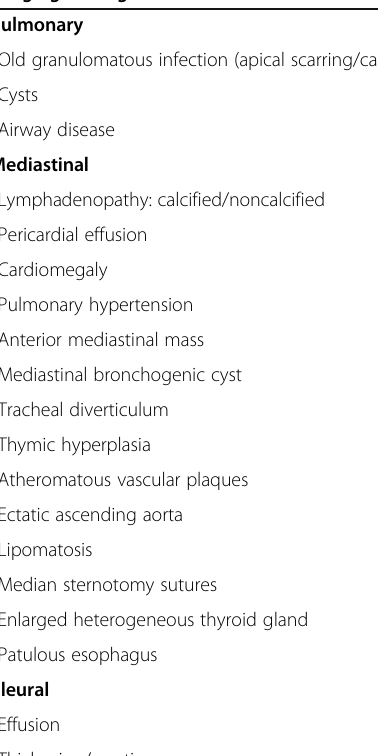
Table 3 Associated CT imaging findings in COVID-19 pneumonia Imaging finding No. of patients (%)